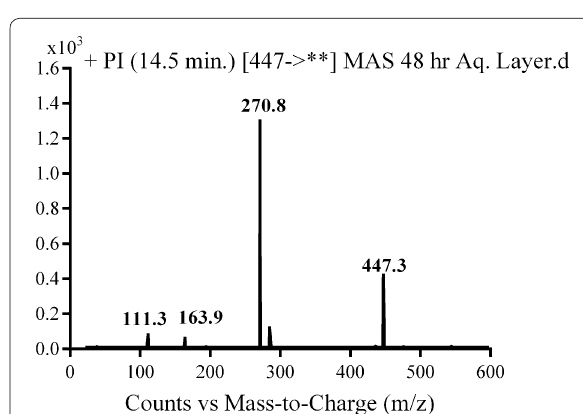
Fig. 15 PI mass spectrum of parent ion (MA3) at m/z